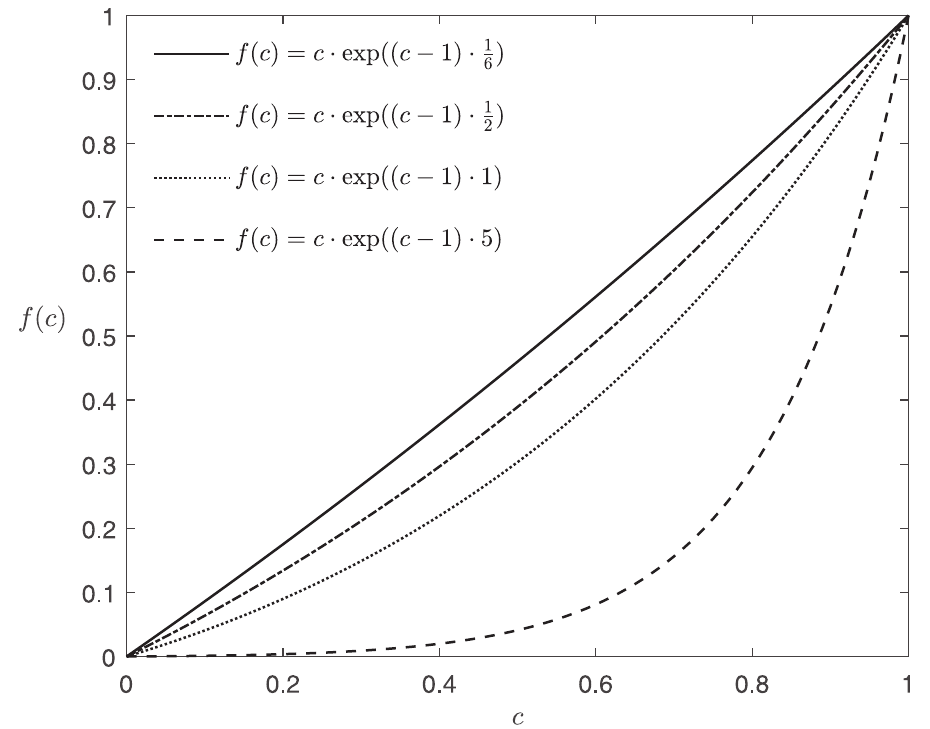
(cid:0) � Fig 1. Behaviour of EA 3 c @ k ; 1 @ k for varying β , where b � 1 (cid:0) 1 k exponential function. The smaller parameter β and the greater the number of appraisals (the greater k ), the closer @ k EA 3 c @ k ; 1 k